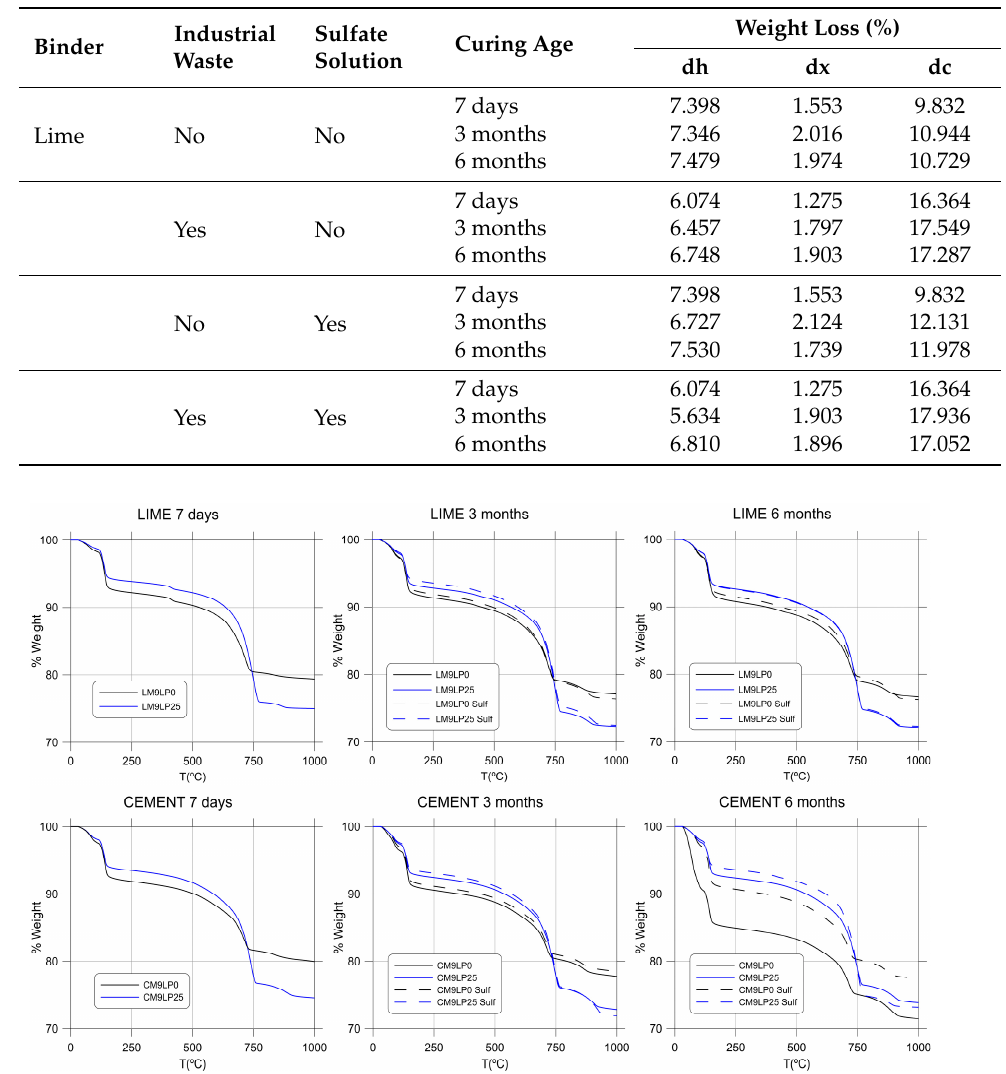
Figure 7. TGA curves at 7 days and at 3 and 6